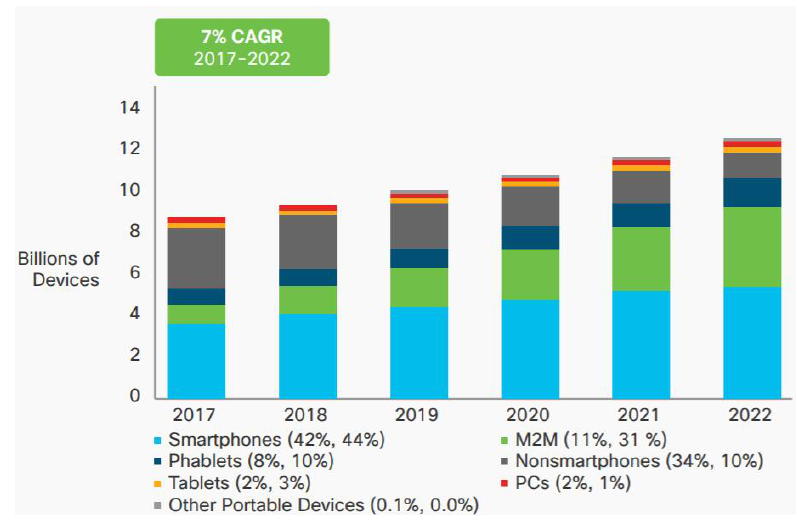
Figure 1. The growth of devices and connections worldwide